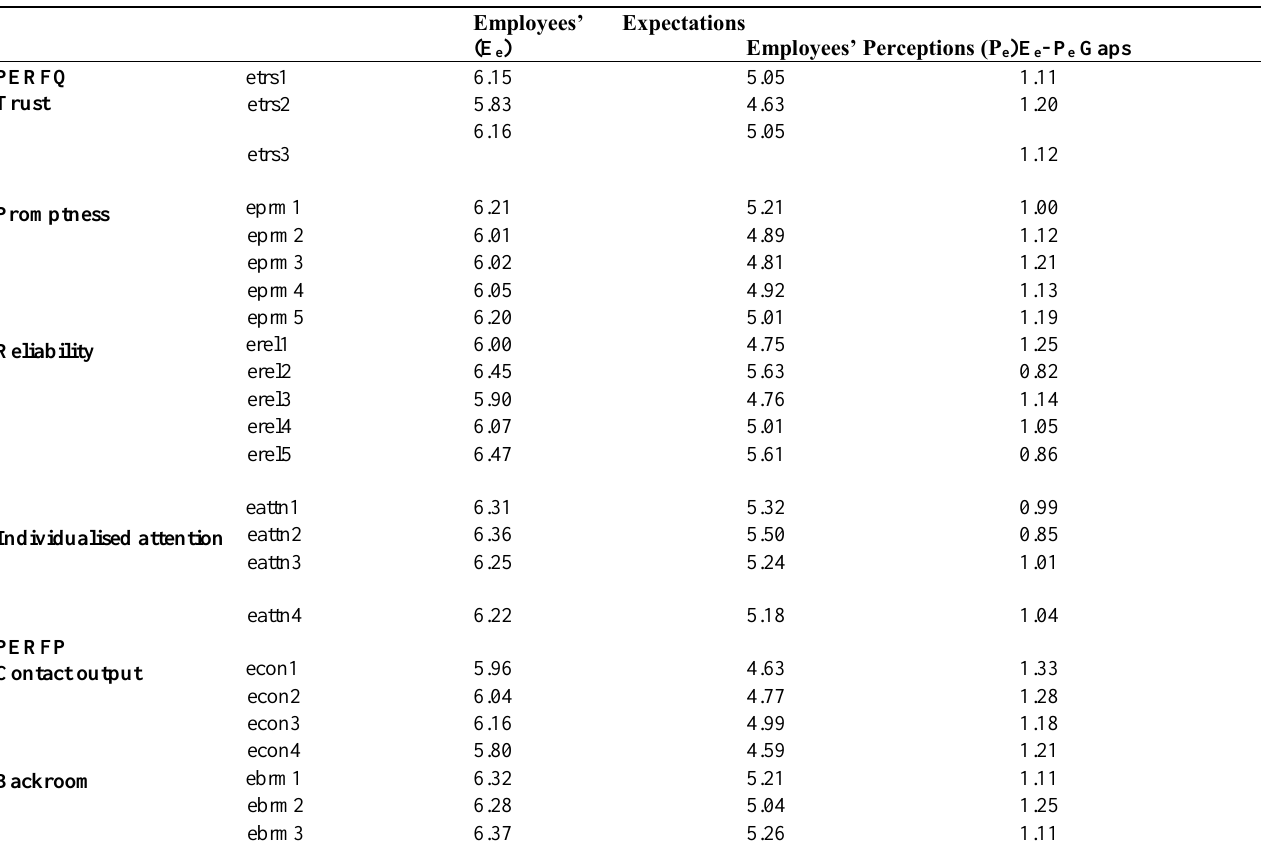
Table 1: Mean values of employees' self-reported expectations and their perceptions of performance quality and